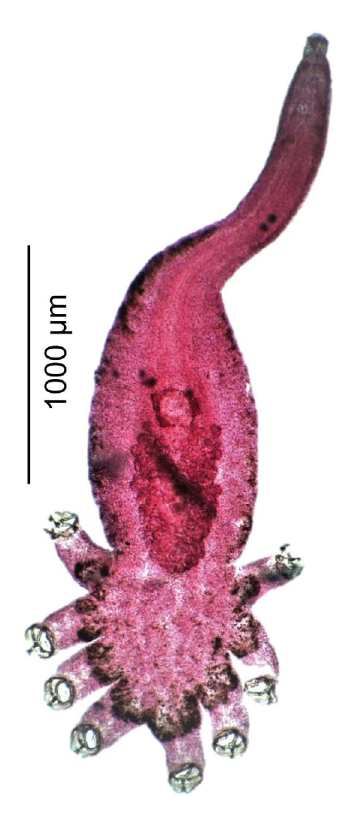
Figure 5. Photograph of a specimen of Cyclocotyla bellones on slide (MNHN HEL1317). Carmine staining (red). Note that the walls of the intestine are lined by dark black pigment from indigested blood, especially in the distal parts of the